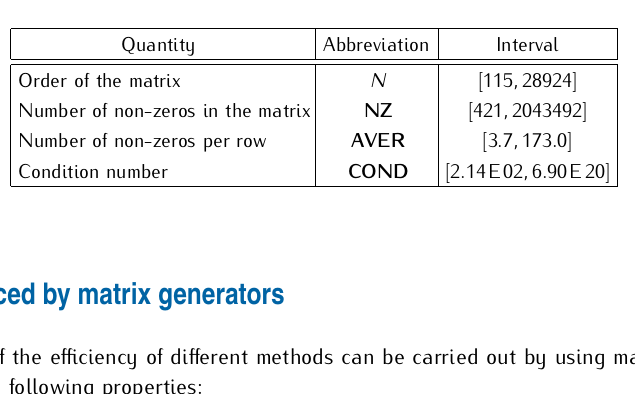
Table 2. Intervals for some quantities related to 64 matrices selected from the Sparse Matrix